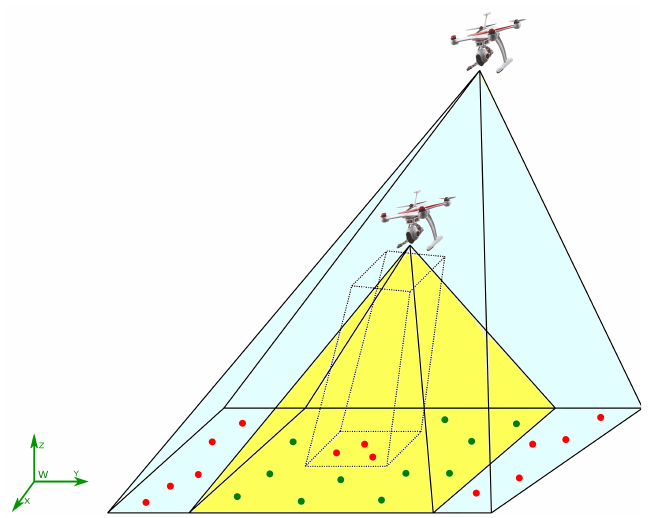
Figure 1. Cooperative monocular-based